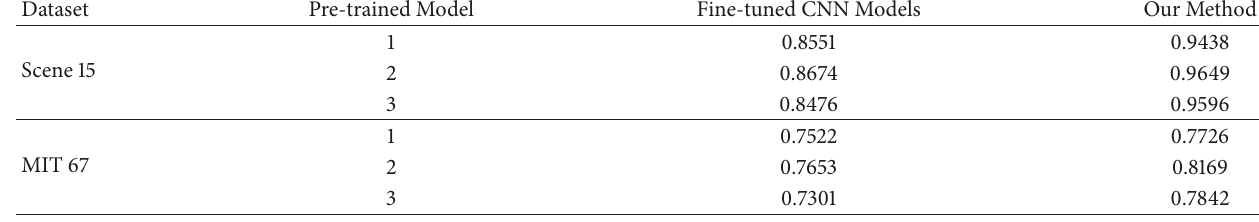
Table 5: Result comparison between fine-tuned CNN models and the proposed method.